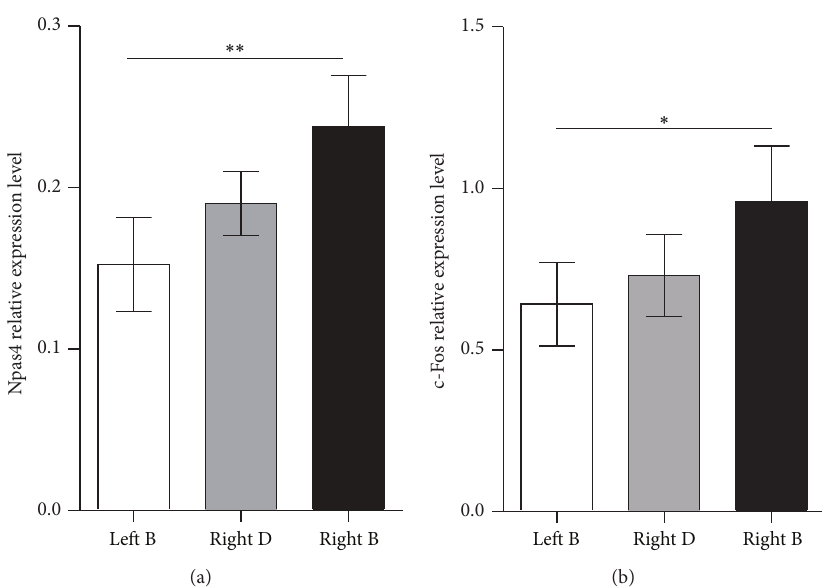
Figure 6: Training induced changes in Npas4 (a) and c-Fos (b) expression. Right B corresponds to the trained row of barrels, right D to control row of barrels in the same hemisphere, and left B to control row B in the other hemisphere. Npas4 and c-Fos have similar pattern of expression following the training procedure: their expression is elevated in the trained row B in comparison with the control side; mean ± SEM ∗ 𝑃 < 0.05 ; ∗∗ 𝑃 < 0.01